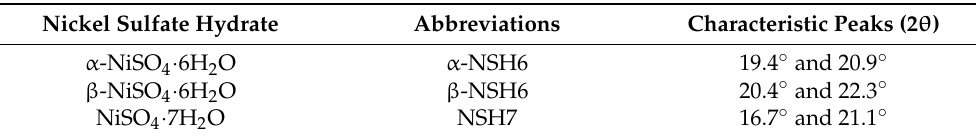
Table 2. Overview of the nickel sulfate hydrates, and their abbreviations used in this work, and selected characteristic peaks with highest intensities. The selected peaks were used for identification and comparison of products from the experiments in this